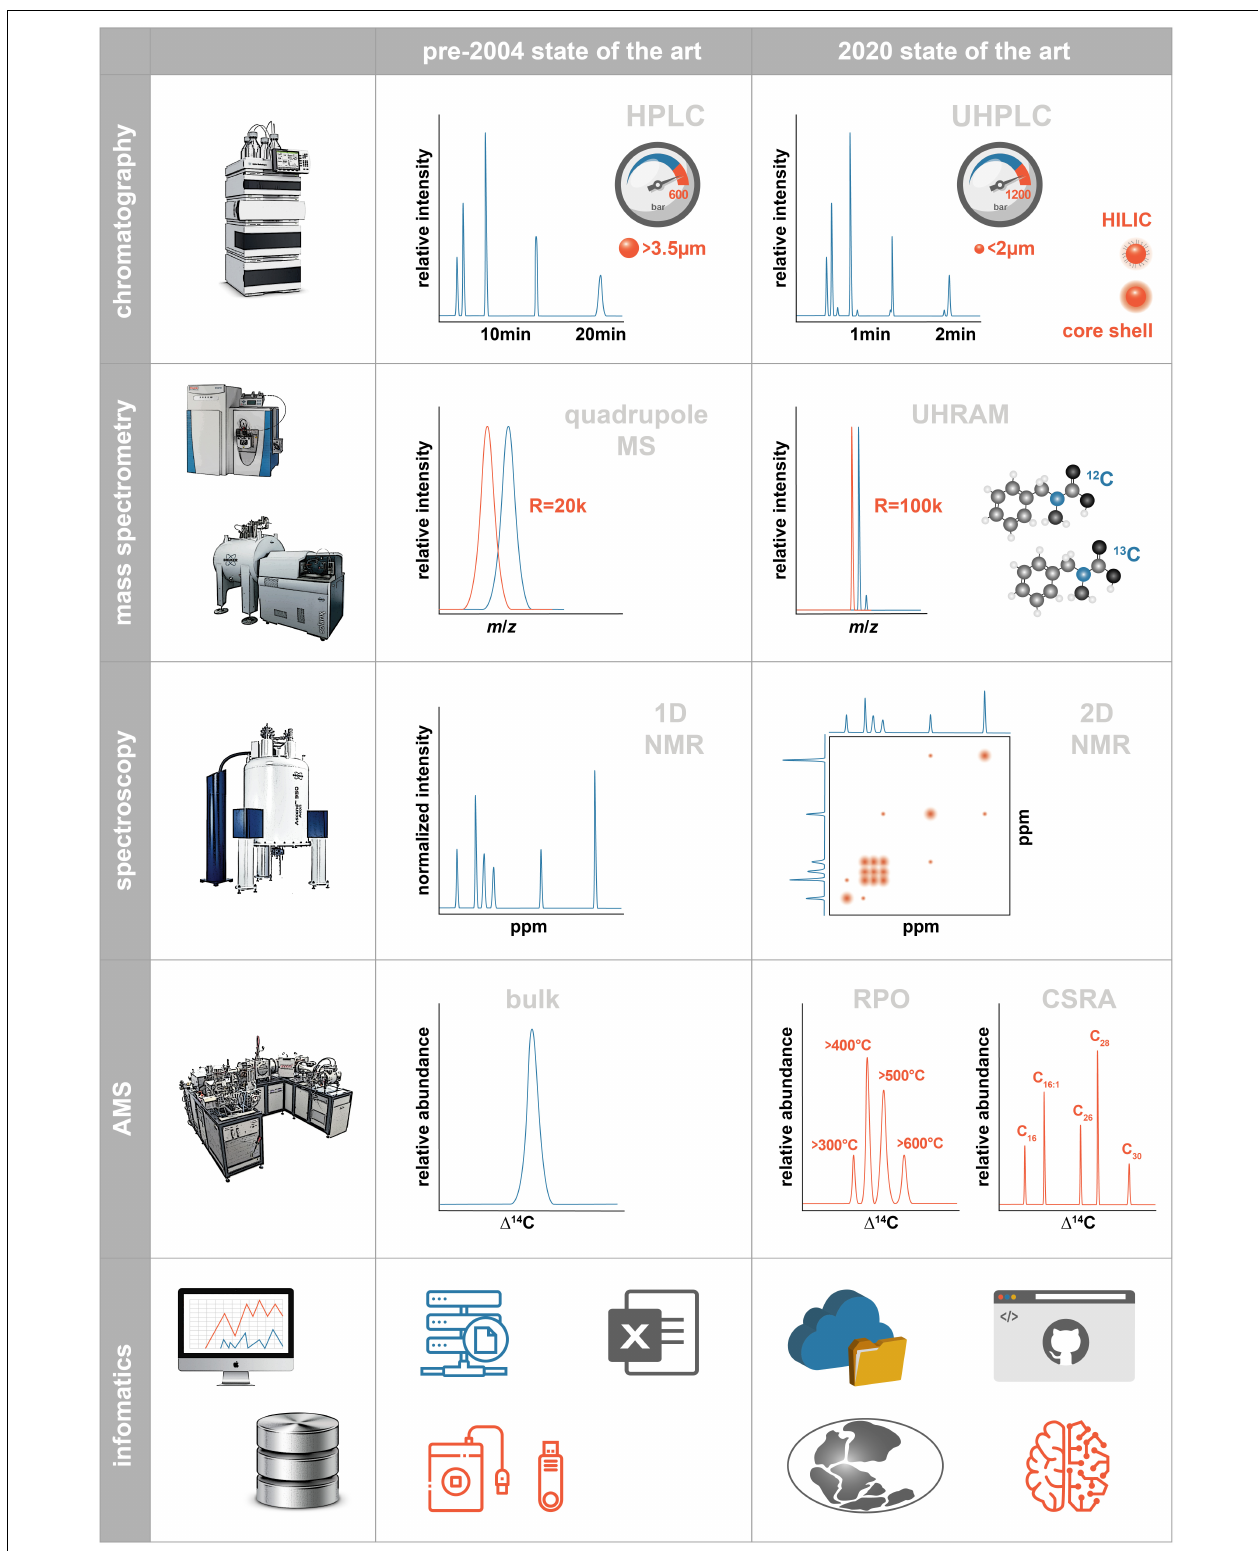
FIGURE 1 | Schematic illustrating the state of analytical methodologies available for marine organic biogeochemistry prior to 2004 and at present. Abbreviations are described in the text.